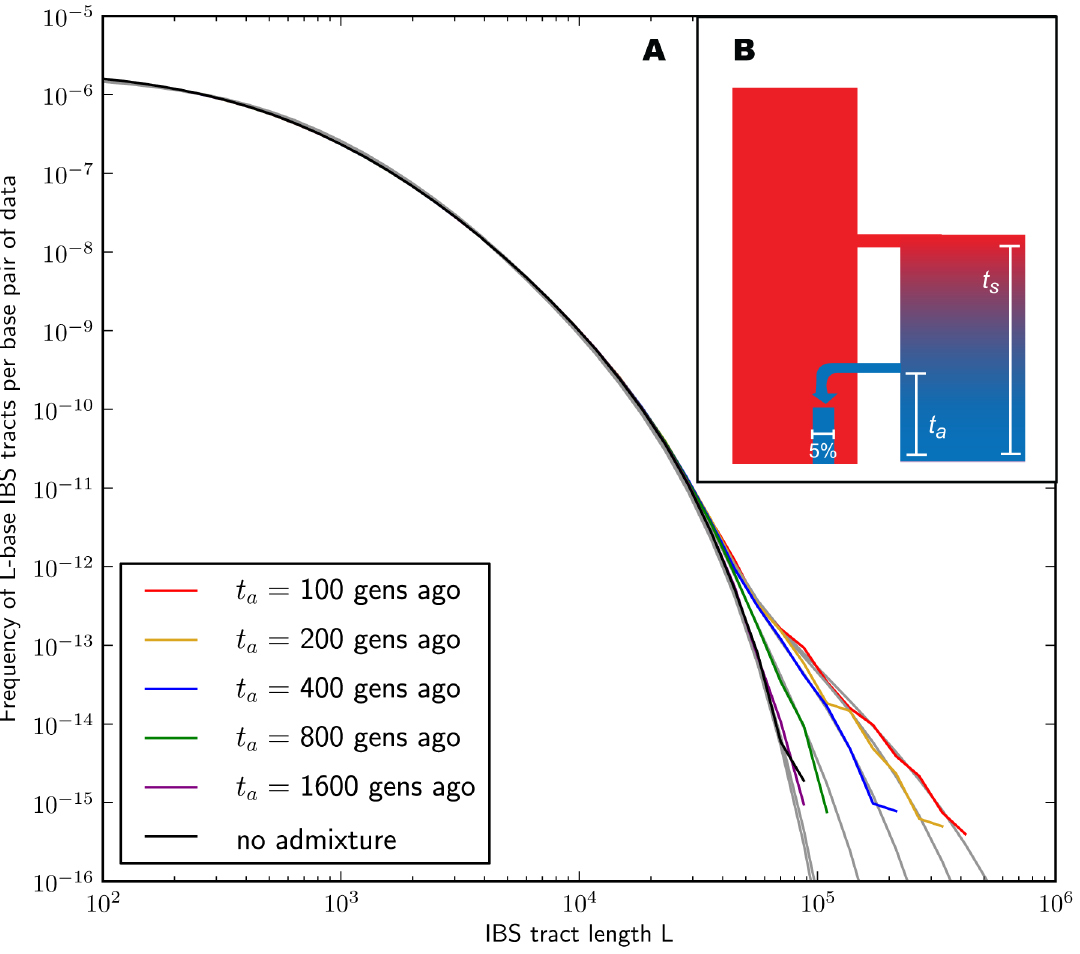
Figure 2. Spectra of IBS sharing between simulated populations that differ only in admixture time. Each of the colored tract spectra in Figure 2A was generated from 4 : 8 | 10 10 base pairs of sequence alignment simulated with Hudson’s MS [68]. The IBS tracts are shared between two populations of constant size 10,000 that diverged 2,000 generations ago, with one haplotype sampled from each population. 5% of the genetic material from one population is the product of a recent admixture pulse from the other population. Figure 2B illustrates the history being simulated. When the admixture occurred less than 1,000 generations ago, it noticeably increases the abundance of long IBS tracts. The gray lines in 2A are theoretical tract abundance predictions, and fit the simulated data extremely well. To smooth out noise in the simulated data, abundances are averaged over intervals with exponentially spaced endpoints t 1 : 25 n s